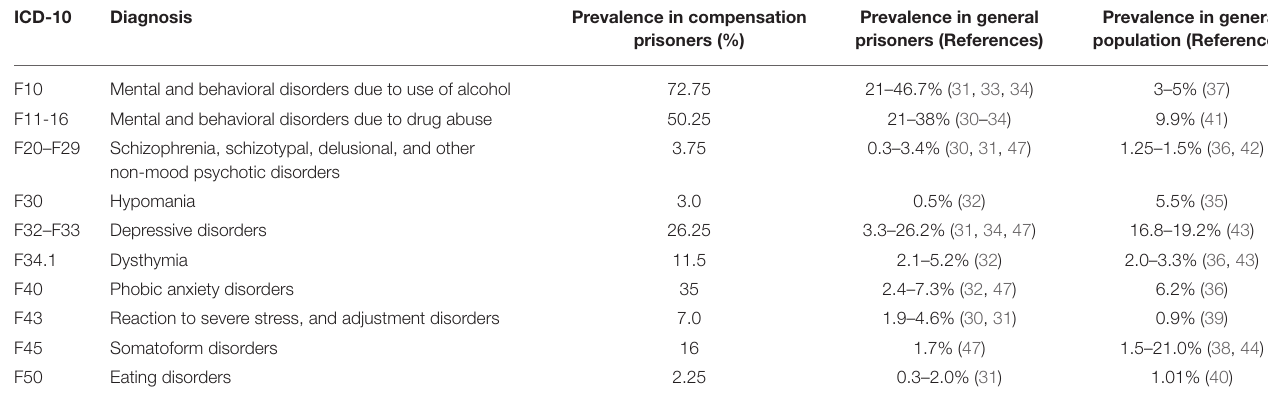
TABLE 1 | Overview of the average prevalence of mental disorders compensation prisoners, general prisoners and in the general population. ICD-10